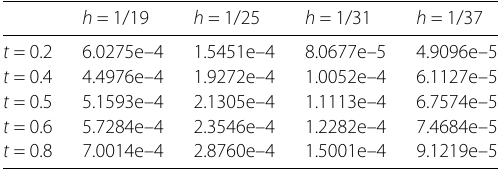
Table 7 The maximum errors of Algorithm 2 to Example 2 for τ = 0.0004